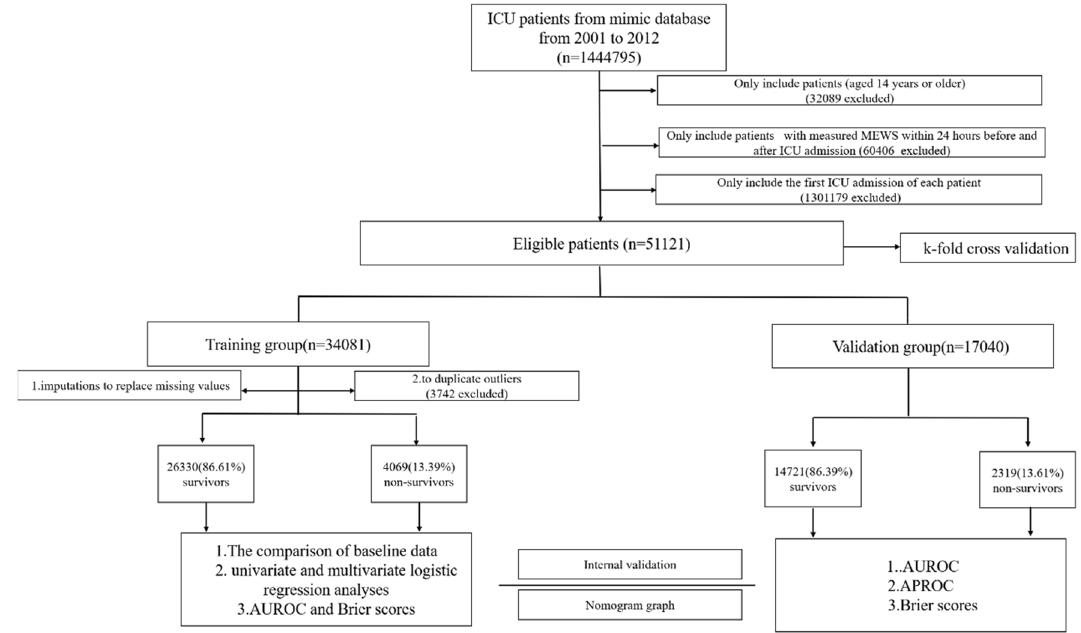
Figure 1. Study population and protocol flowchart. Flow chart illustrating the major steps in the development and validation of the mionl-MEWS